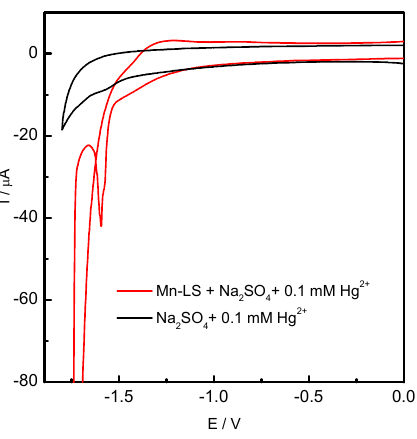
Figure 1. Cathodic cyclic voltammograms of Mn-lignosulfonate (Mn-LS) in the presence of supporting electrolyte (Na 2 SO 4 ) and mercury salt (Hg(NO 3 ) 2 ) and supporting electrolyte with mercury salt lacking Mn ‐ LS.